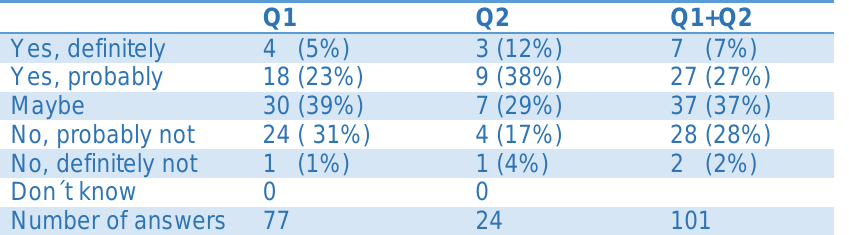
Table 4: Statement. Cost overruns would be considerably less if the client let external reviewers evaluate the project and calculation in advance